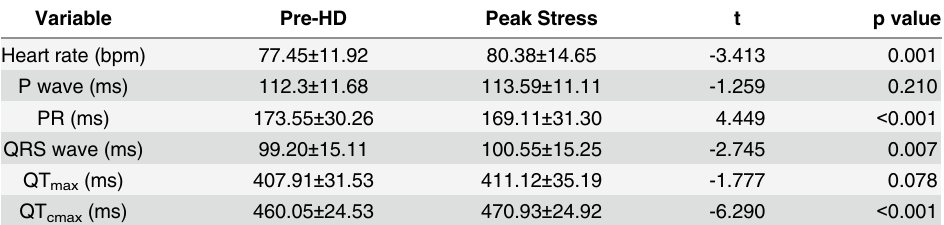
Table 3. Electrocardiogram variables in different time points in patients undergoing HD (n = 132).